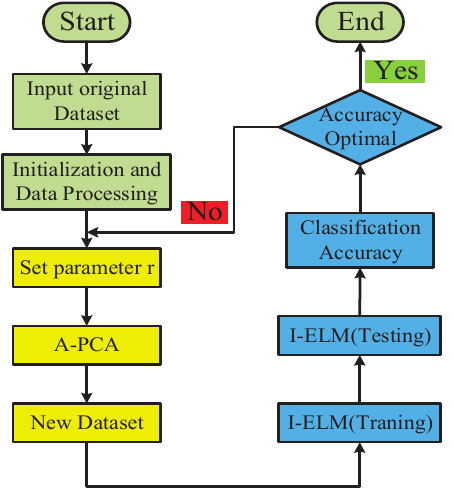
Figure 4. The work-flow chart of